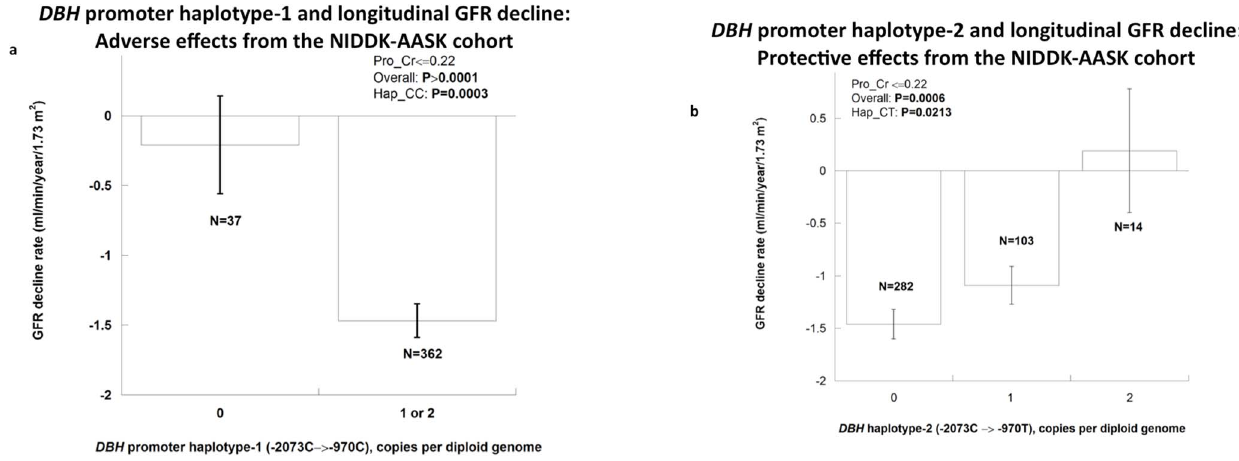
Figure 5. DBH promoter haplotype activity: Longitudinal effects on GFR decline in the NIDDK-AASK study population . GFRs were determined longitudinally by [ 125 I]-iothalamate clearance. Subjects without excessive proteinuria at entry (urine protein/creatinine ratio # 0.22 gm/ gm at entry, N=428) were analyzed. a. DBH promoter haplotype-1 (C R C) displaying a significant association (p=0.0006) with GFR slope in an age-adjusted model. b. DBH promoter haplotype-2 (C R T) displaying a significant association (p=0.0006) with GFR slope in an age-adjusted model.